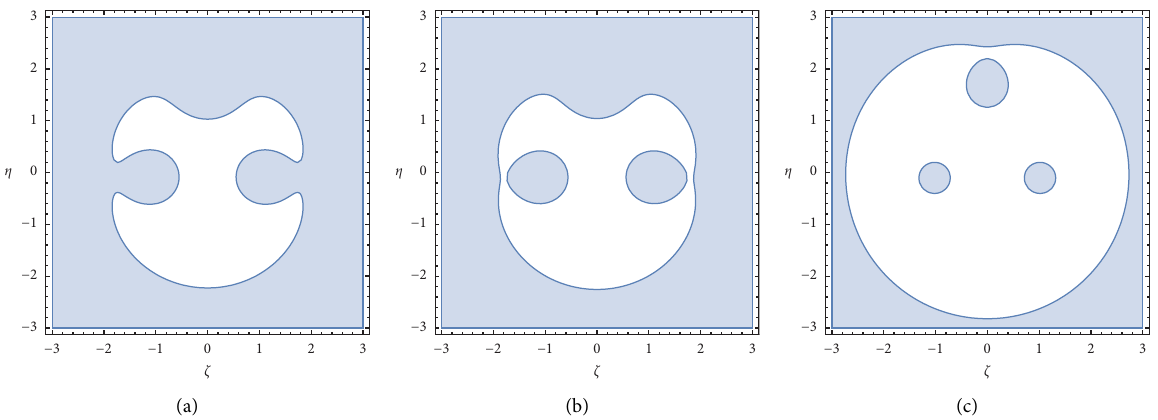
Figure 11: Case III: regions of motion for m